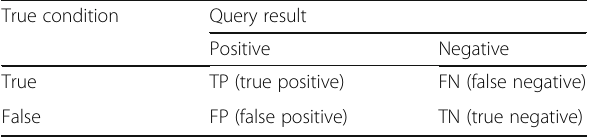
Table 2 Confusion matrix of search result True